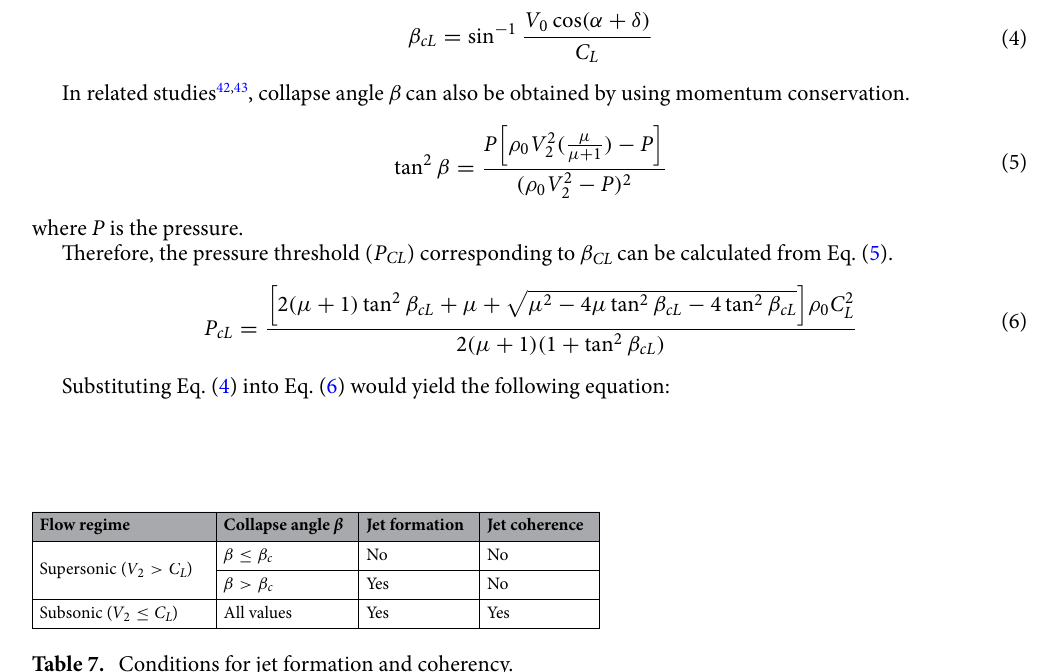
Table 7. Conditions for jet formation and